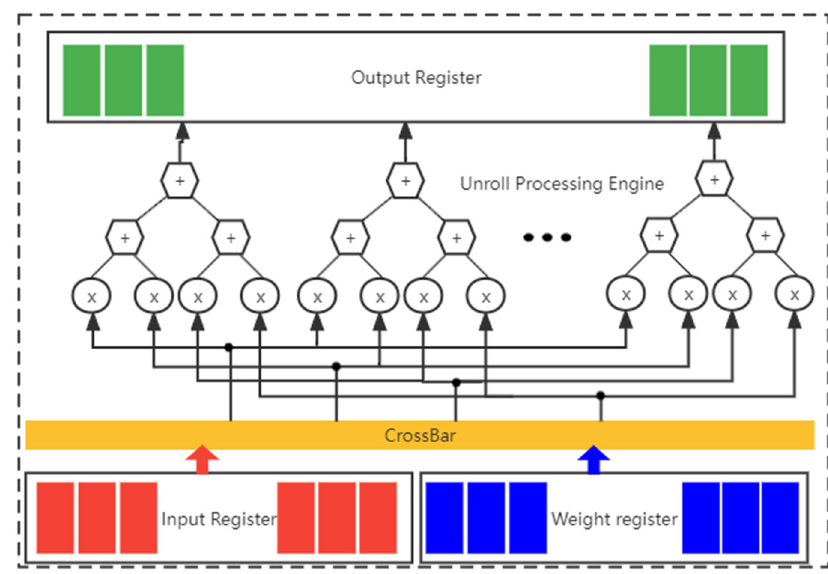
Figure 9. The convolution function block of the proposed accelerator structure. Table 3. The utilization of convolution computing function before and after optimizing.